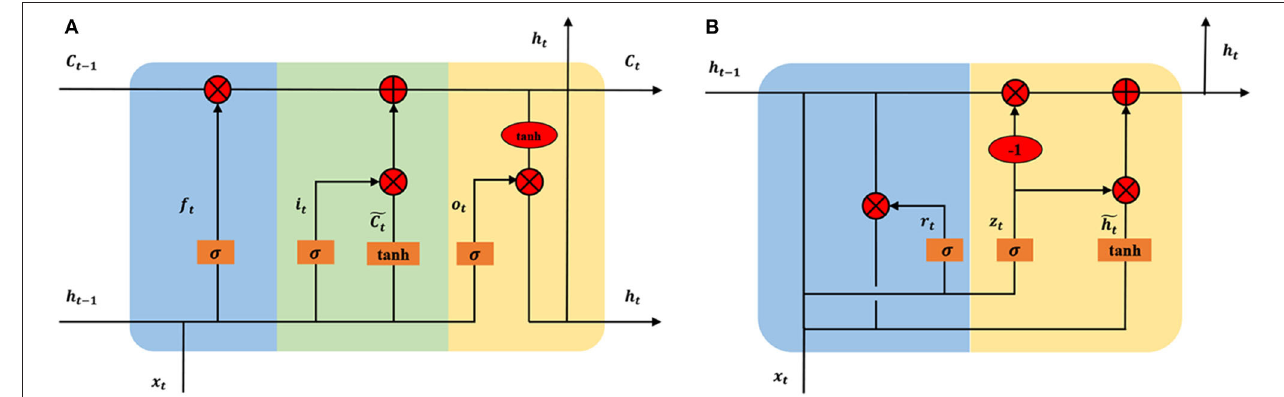
FIGURE 7 | Architectures of long short-term memory (A) and gated recurrent unit (B) In the subfigure (A) , the blue, green, and yellow represent the forget gate f t , input, gate i t , and output gate o t , respectively. In the subfigure (B) , the blue and yellow represent the reset gate r t and update gate z t , respectively. x t is input vector and h t is the hidden state. To keep the figure simple, biases are not